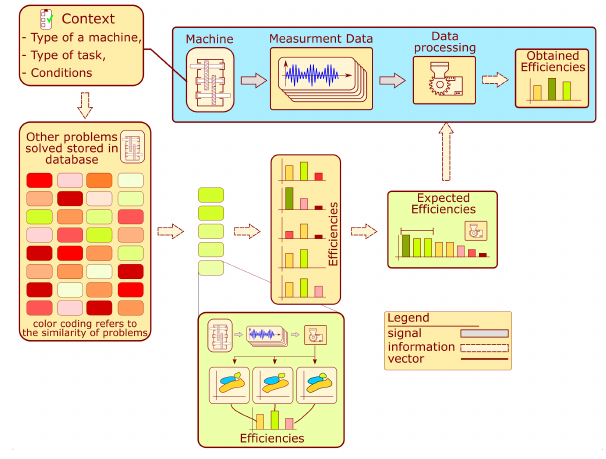
Figure 2. Principle of processing recommendation algorithm.